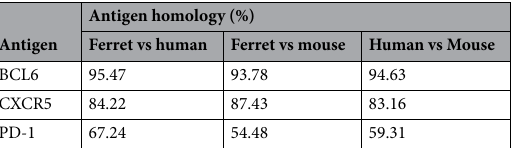
Table 1. Antigen homology of ferret, human and mouse BCL6, CXCR5 and PD-1.